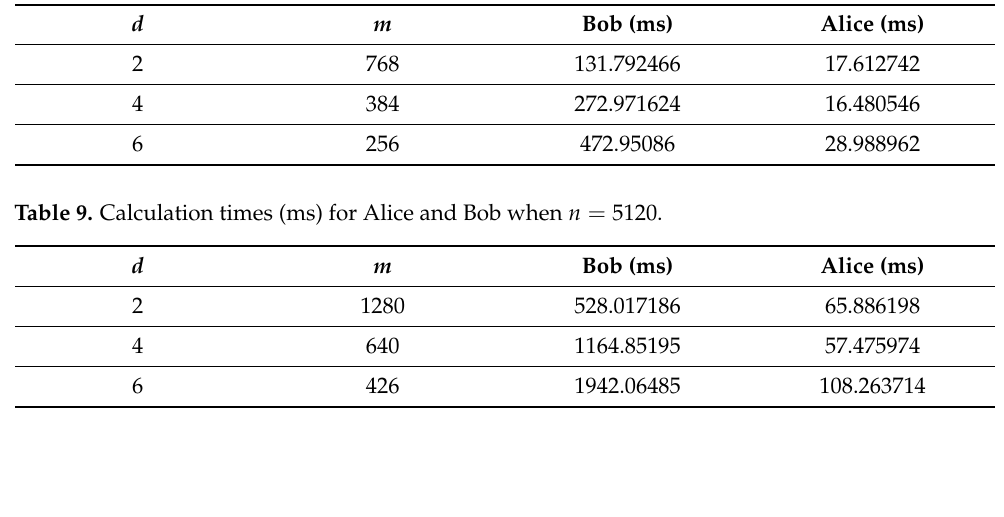
Table 8. Calculation times (ms) for Alice and Bob when n = 3072.